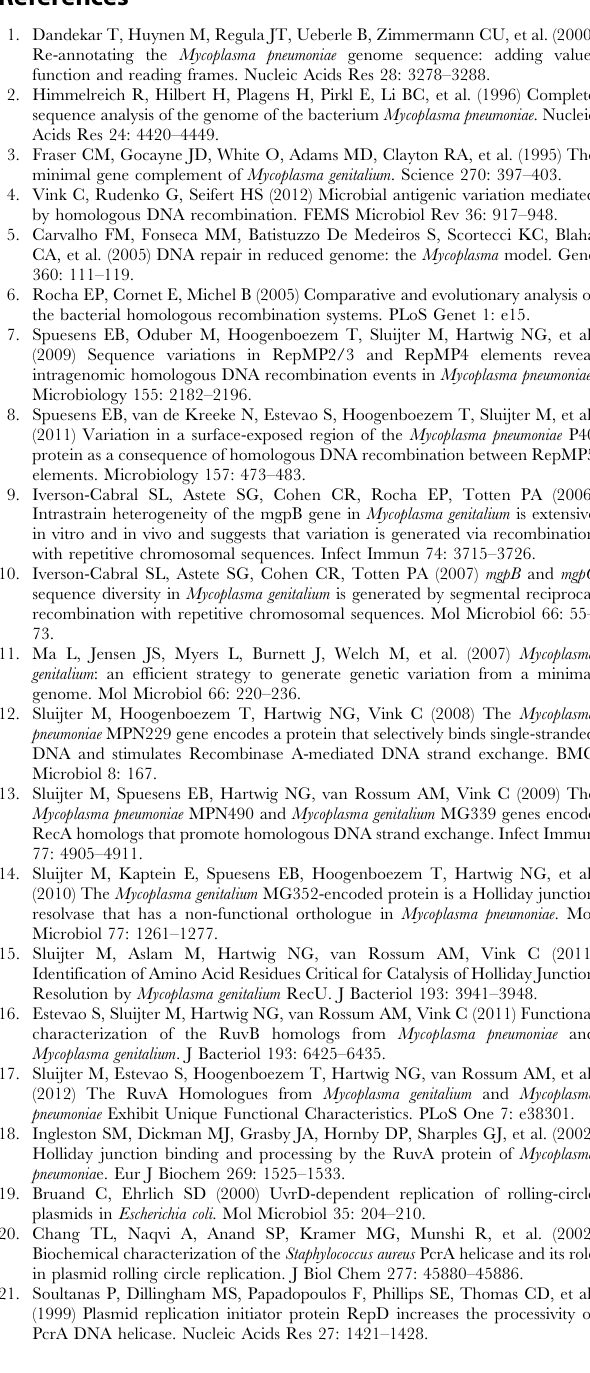
Table S1 Oligonucleotide primers used for the cloning of ORFs encoding the PcrA-like helicases from M. pneumoniae and M. genitalium. a The different ORFs are from M. pneumoniae strains M129 (MPN340 and MPN341) and FH (MPNE_0394), and from M. genitalium strain G37 (MG244). b Restriction endonuclease recognition sites that were incorporated in the primer sequences for cloning purposes are indicated in italics. The TGG codons (or the complementary sequences CCA) that were incorporated in the oligonucleotides in order to modify the TGA codons within the native ORFs, are